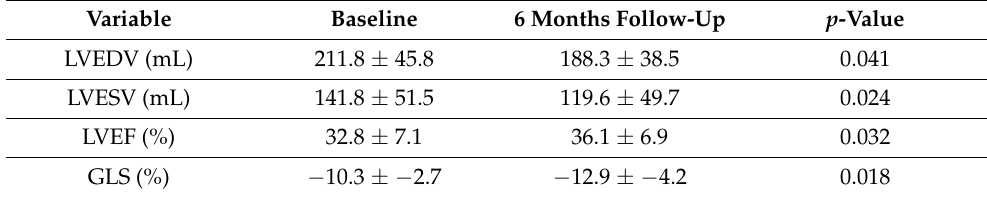
Table 2. Echocardiographic index of left ventricular systolic function of the study population.